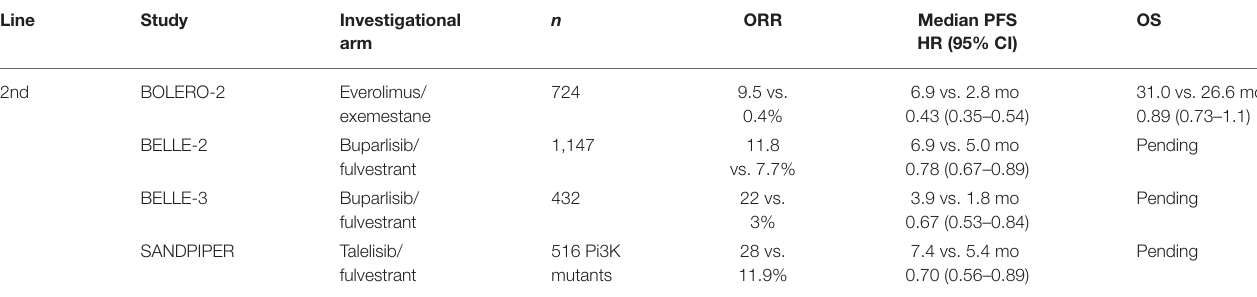
TABLE 3 | Summary of phase III clinical trial results for PI3K and mTOR inhibitors in metastatic HR positive, HER2 negative breast